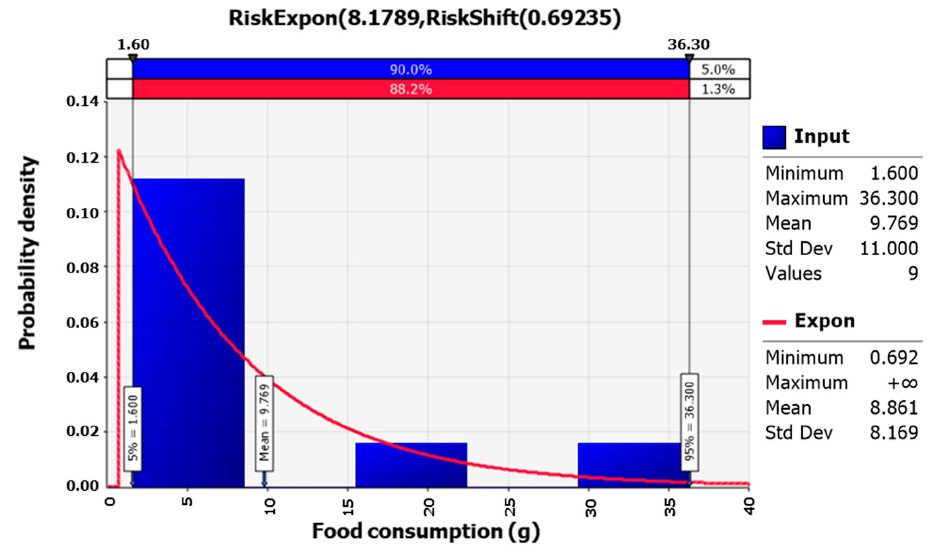
Figure 4. Probability distribution for fermented clam intake from the Korea Health and Nutrition Examination Survey in 2018.